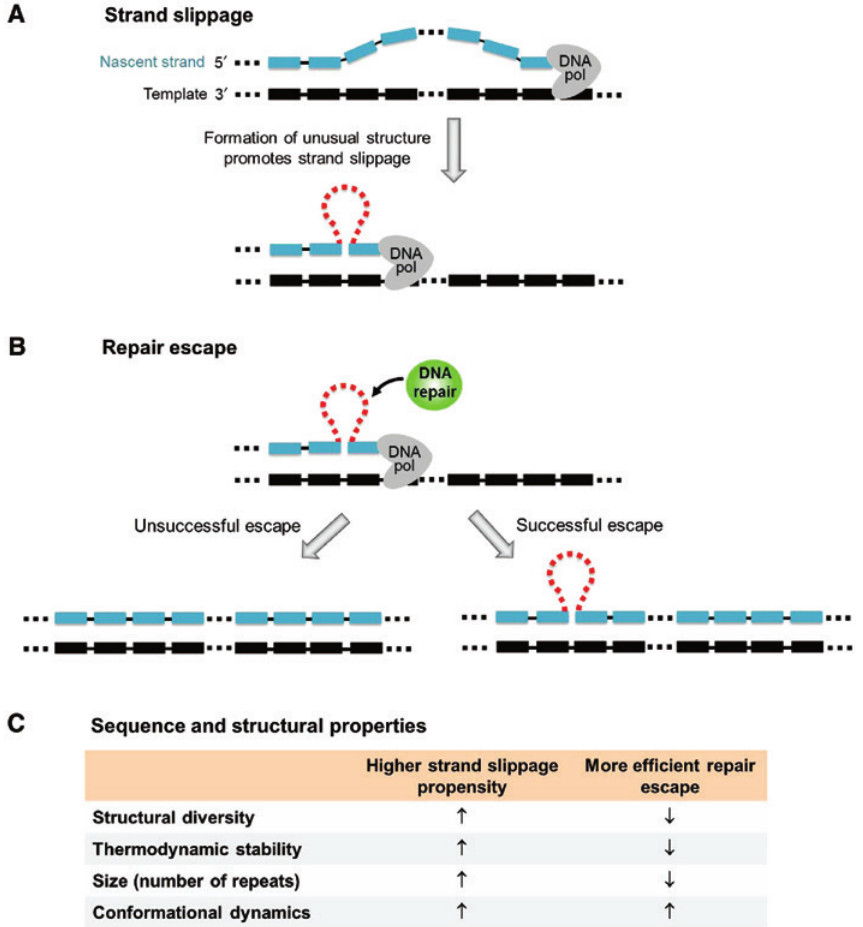
Figure 2: A proposed pathway of repeat expansion during DNA replication. (A) Slippage occurs at the 3 ′ -terminal of the nascent strand. The formation of an unusual structure promotes strand slippage via stabilizing the slipped strand. (B) Repeat expansion occurs if the unusual structure successfully escapes from DNA repair. (C) This table summarizes the sequence and structural properties that lead to a higher strand slippage propensity and more efficient repair